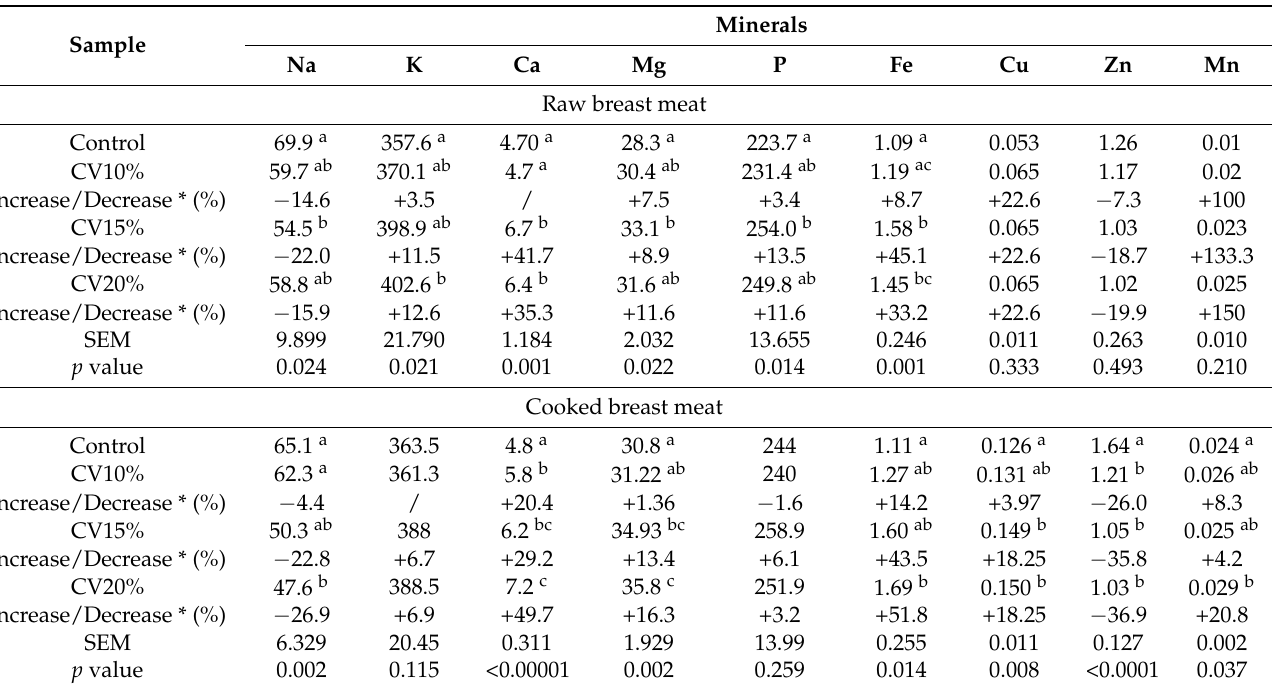
Table 6. Mineral composition (mg/100 g) of raw and cooked breast muscle of broilers chickens fed different levels of C. vulgaris for 40